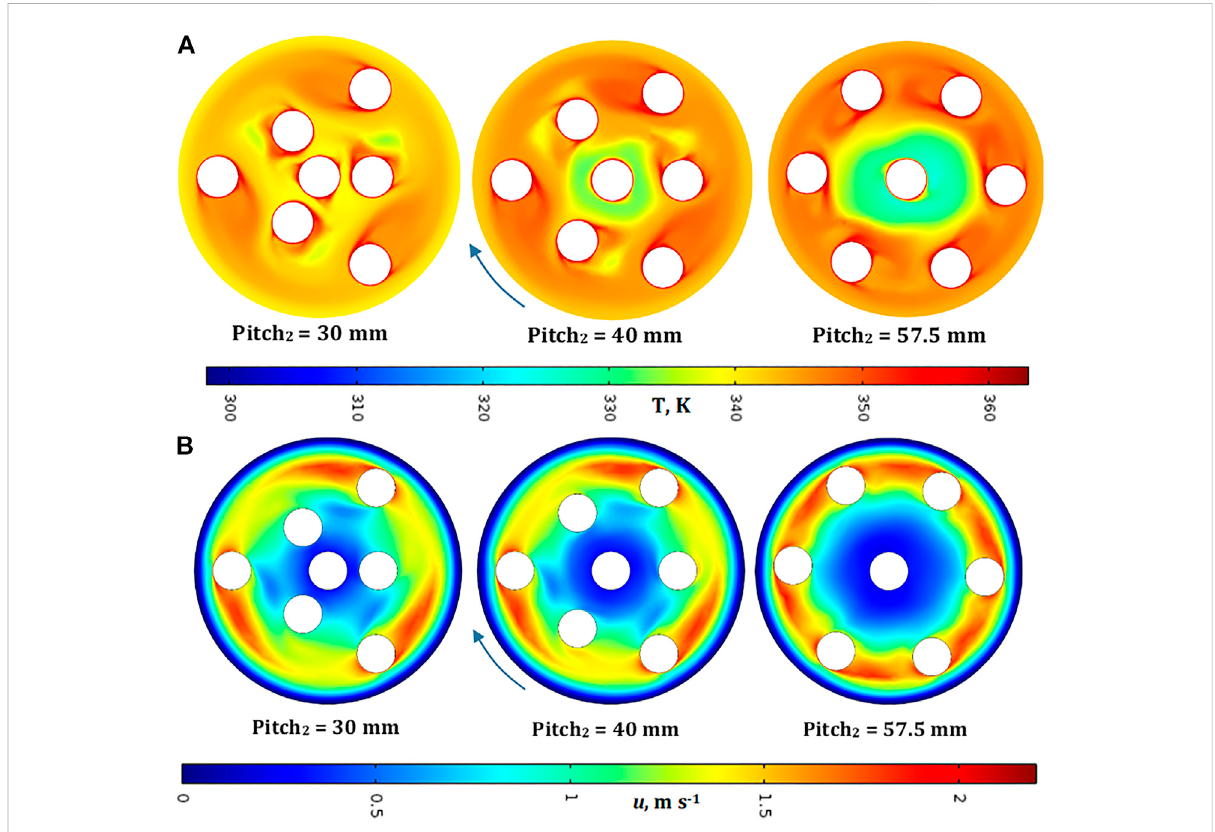
FIGURE 8 (A) Temperature and (B) velocity pro fi les at 5 s for different pitch 2 values in adiabatic conditions in alternate con fi guration. Fluid:water, pitch 1 = 57.5 mm, T spot = 90 ° C, T ext = 25 °